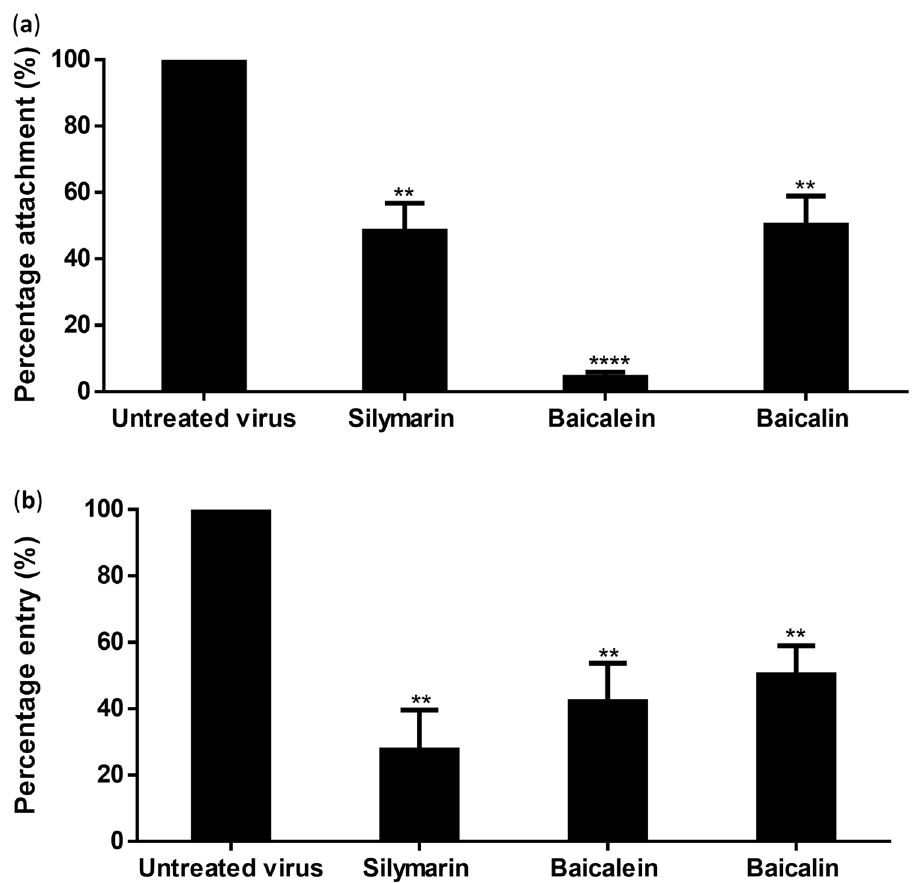
Figure 5. Effects of flavonoids on the attachment and entry of DENV-3 to Vero cells. The viral attachment ( a ) and entry ( b ) inhibition were calculated as the number of foci formed by the silymarin, baicalein, and baicalin- treated virus compared to the untreated virus. Data presented as mean ± SEM. Error bars indicate the range of values obtained from three independent experiments. **P < 0.01, * ***P < 0.0001 indicates a significant difference between groups compared by t -test.